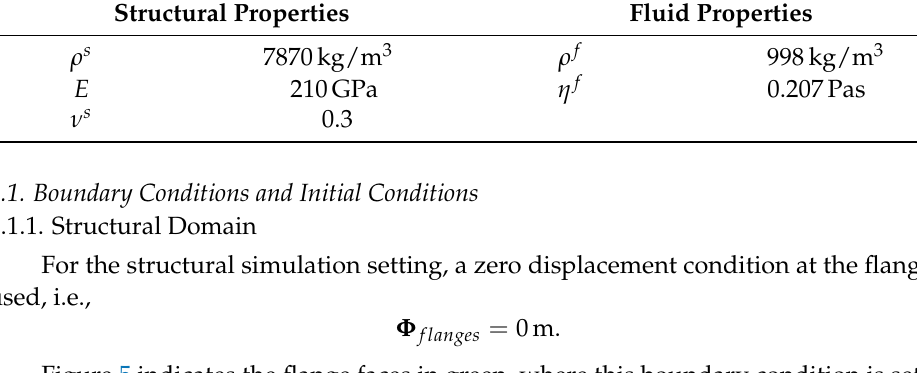
Figure 5 indicates the flange faces in green, where this boundary condition is set.